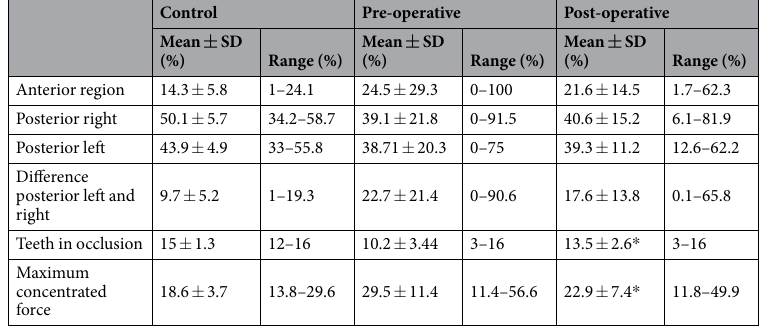
Table 2. T-Scan analysis parameters of the control group and the treatment group before surgery and 1 year after. The asterix ( * ) indicates the statistical significant differences found in the treatment group between the two time points using a Wilcoxon signed-rank test with p < 0.05.